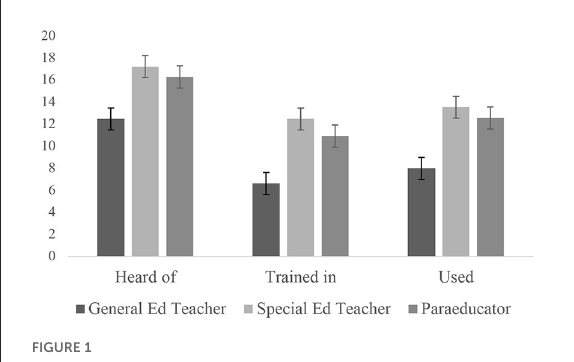
FIGURE1 Number of different practices educators were familiar with, trained in, or used, with standard deviation